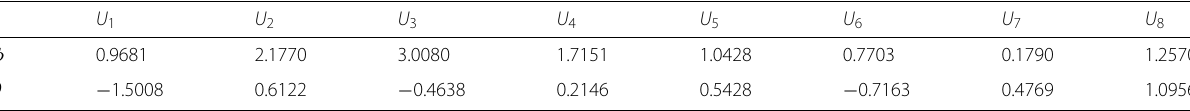
Table 1 The azimuth and elevation angle of the users ( K = 8 ) U